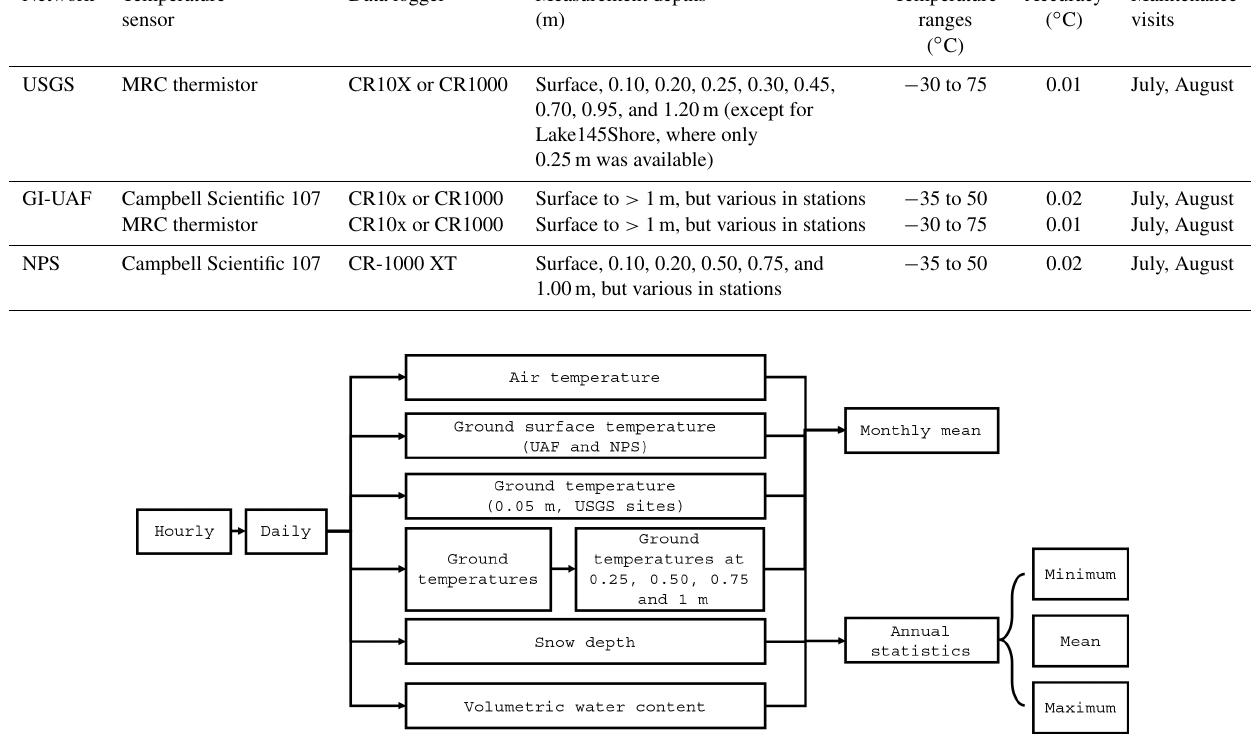
Figure 3. Schematic representation of the data processing workflow used to compile the permafrost dataset in the